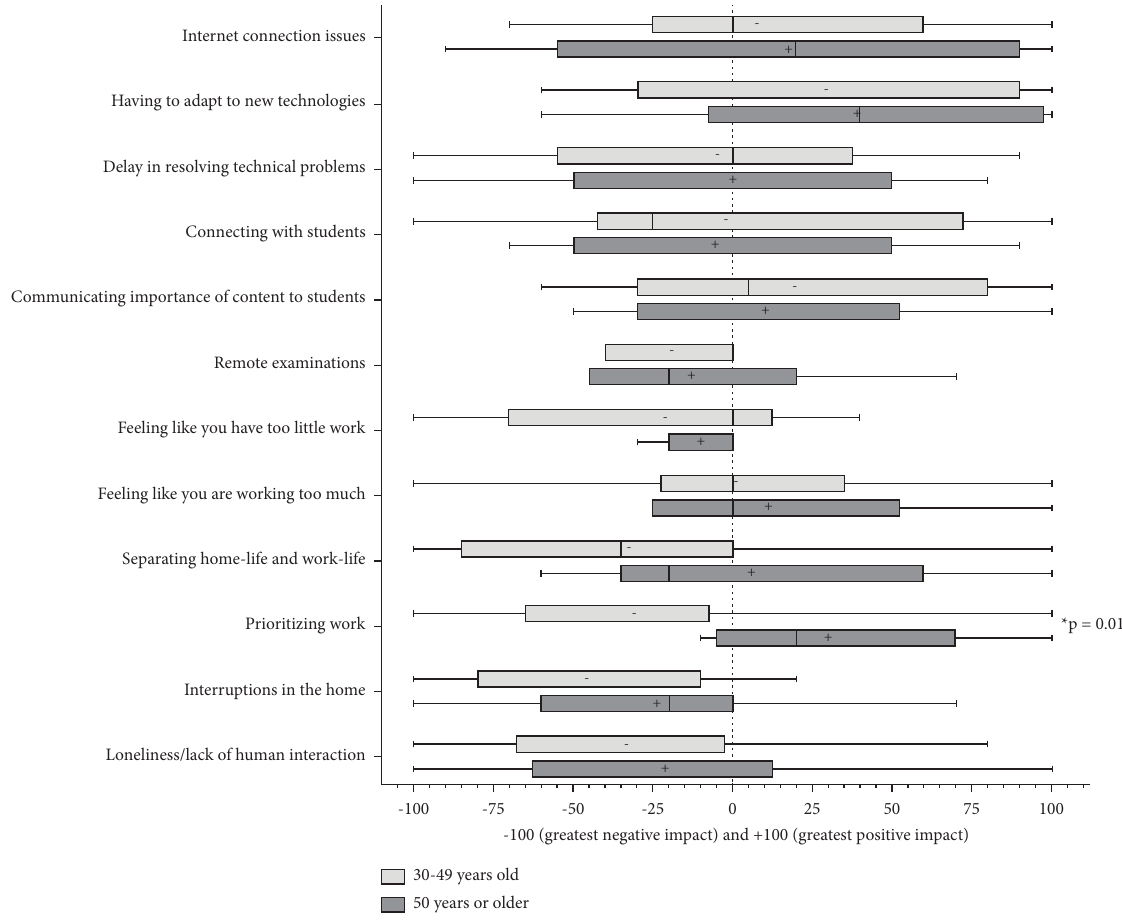
Figure 2: Faculty experience during remote instruction. Table 4: Responses of Detroit Mercy dental faculty to questions regarding social aspects of remote instruction away from the institution. M Median (Mode) Min. Max.